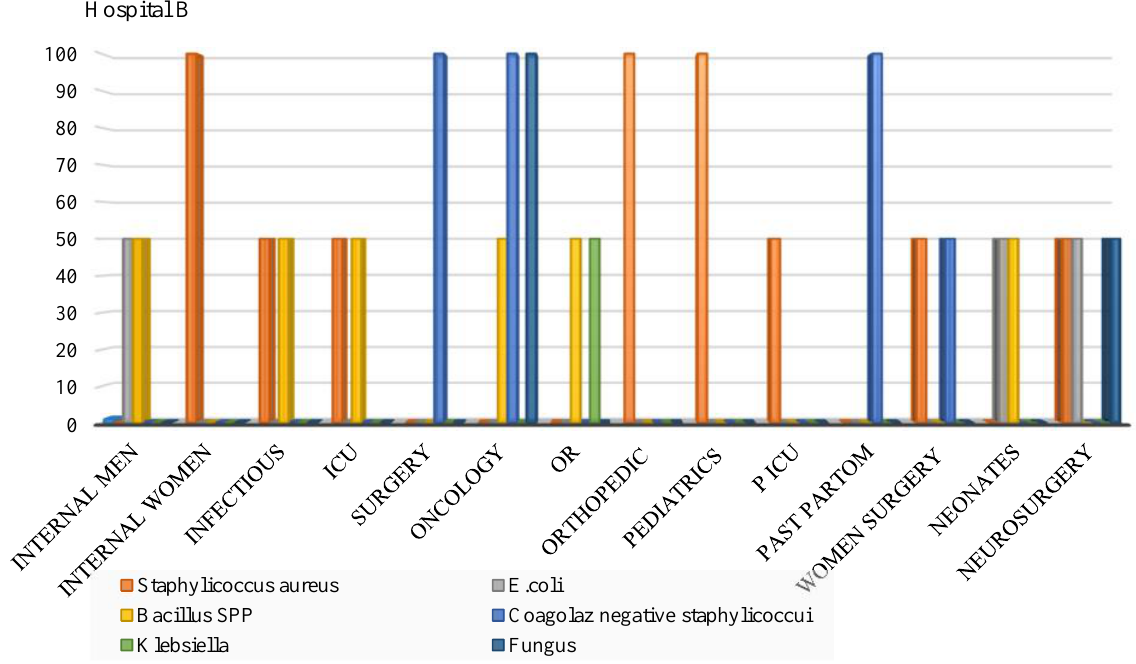
Fig. 5. Bacterial species frequency in different wards of hospital B before disinfection